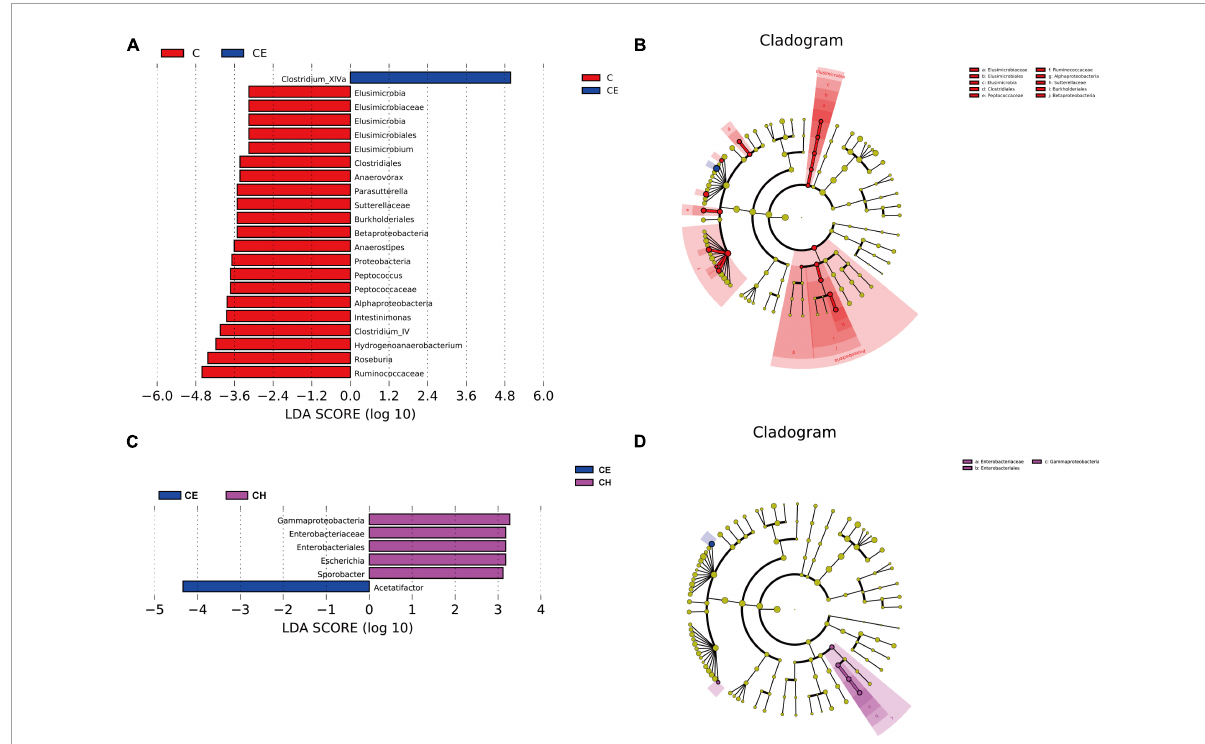
FIGURE9 Linear discriminant analysis of the effect size (LEfSe) analysis of the gut microbiota among three groups. (A,B) The taxonomic cladogram was obtained from the LEfSe analysis of gut microbiota in different groups; (C,D) The LDA effect size of more than four was used as a threshold for the LEfSe analysis. C, control group; CE, cold exposure group; CH, Chinese herbs complex group.